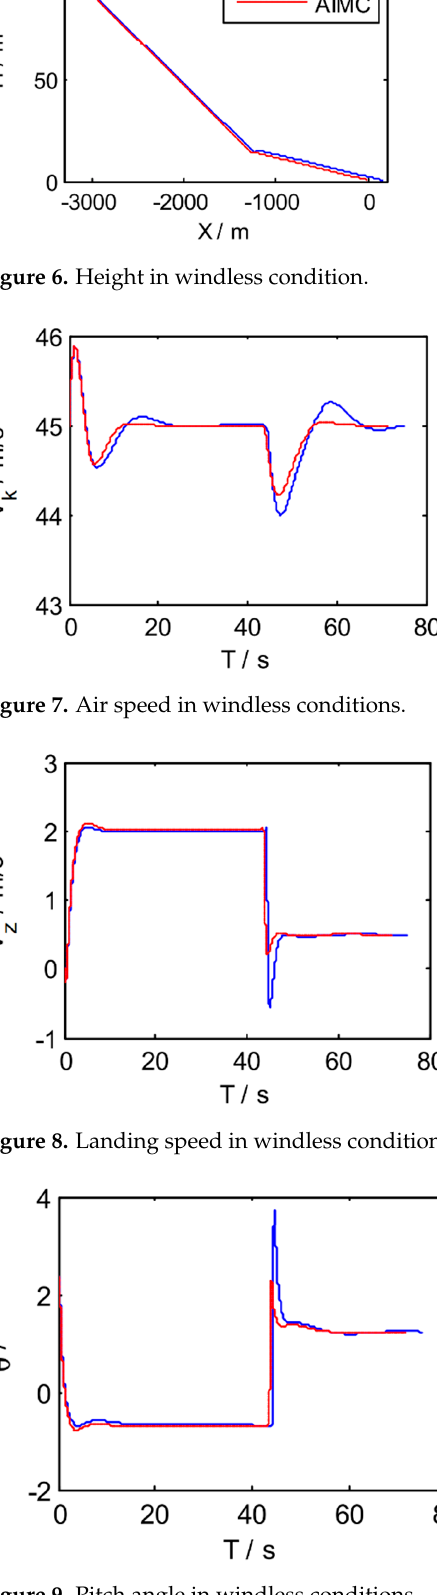
Figure 9. Pitch angle in windless conditions.